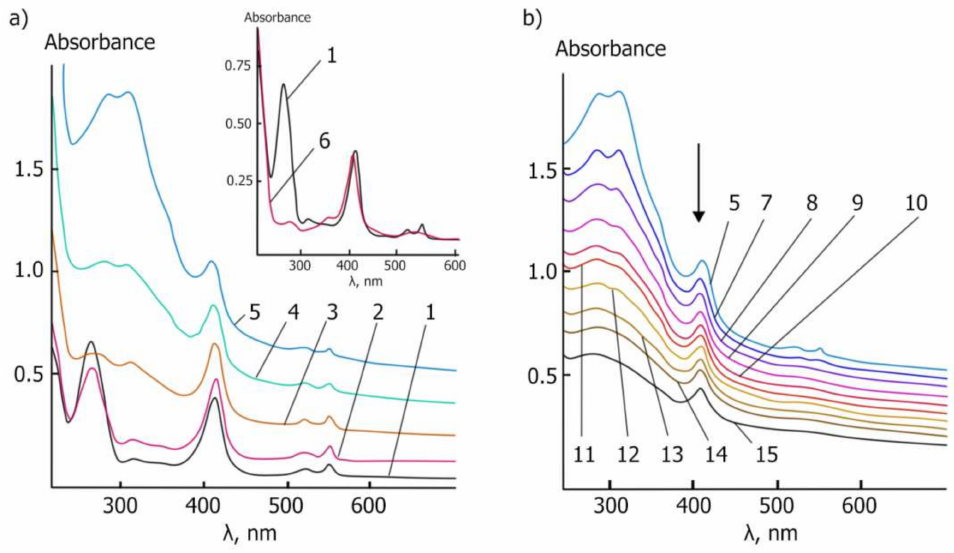
Figure 8. UV-vis spectrum analysis of cytochrome c interaction with CeO 2 NPs. ( a ) The changes in the UV-vis spectra of the CeO 2 NPs and 0.0334 mM ferrocytochrome c (Fe 2+ ) reaction mixture in PBS saline (pH 7.4) with respect to the concentration of CeO 2 NPs. The curves are signified as follows: 1—0 mg/mL, 2—0.25 mg/mL, 3—0.5 mg/mL, 4—0.75 mg/mL and 5—1 mg/mL. Spectra of the initial ferrocytochrome c (curve 1) and ferricytochrome c (curve 6) are presented in the inset. ( b ) Changes in the UV-vis spectra of CeO 2 NPs (1 mg/mL) and 0.0334 mM ferrocytochrome c (Fe 2+ ) reaction mixture over time (Table